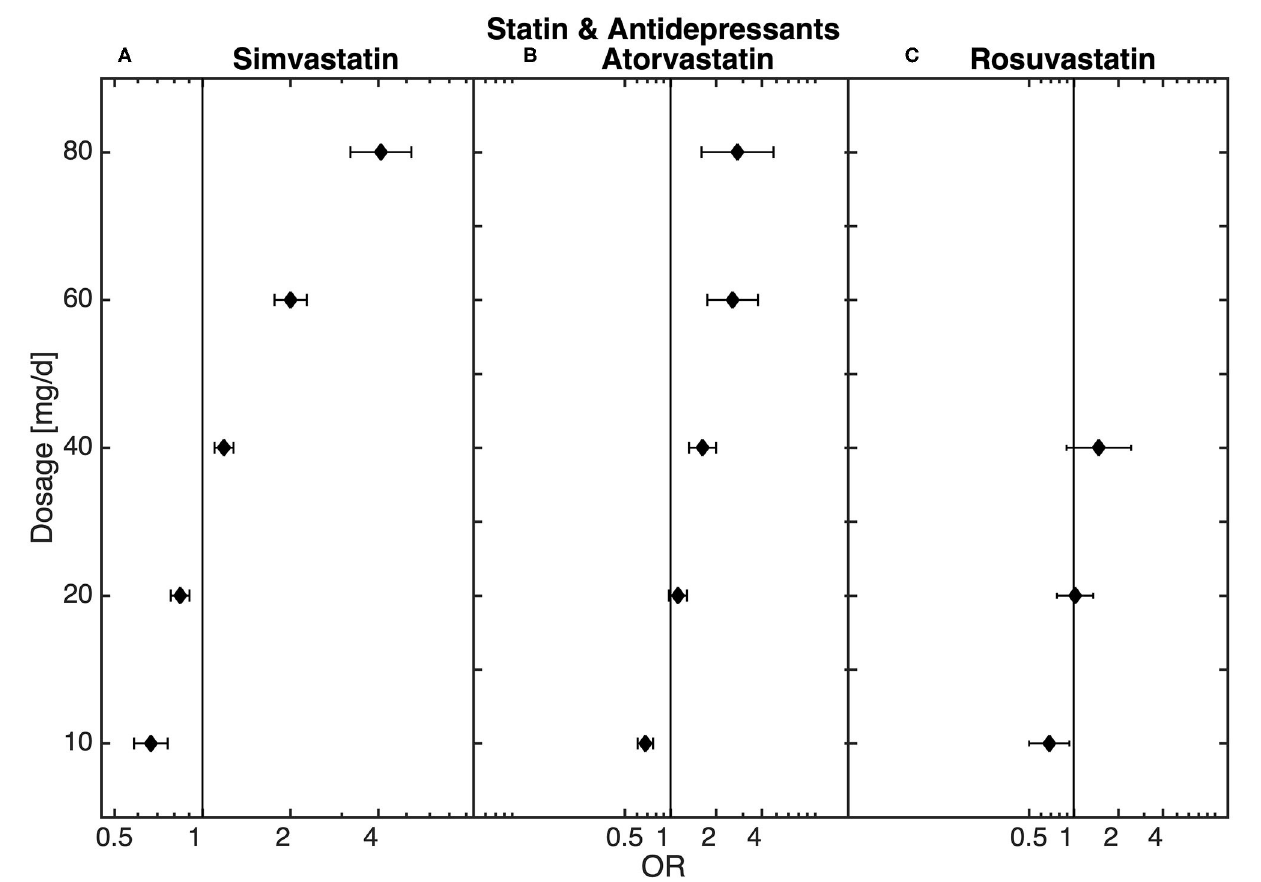
FIGURE 3 | Dose-dependent relationship between (A) simvastatin, (B) atorvastatin, and (C) rosuvastatin and antidepressant medication ( n = 98,913) obtained from the logistic regression